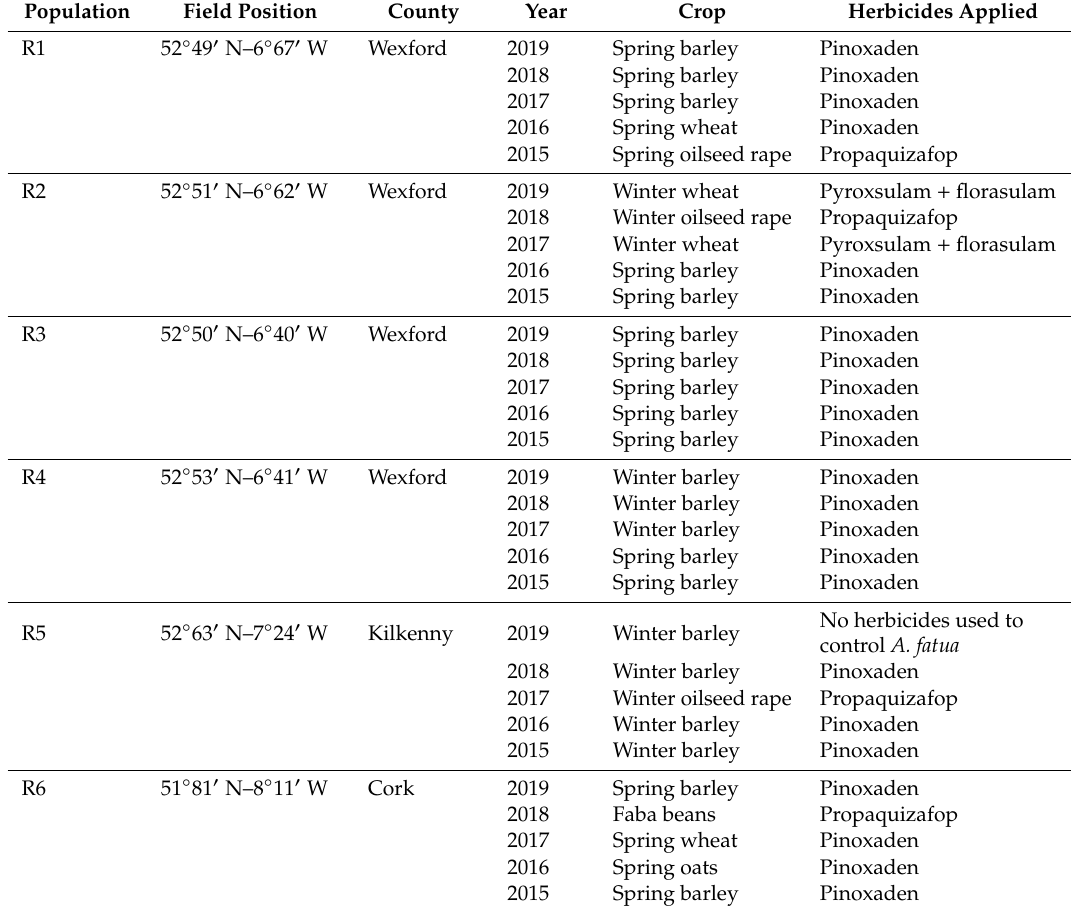
Table 1. Field history of the six A. fatua test populations collected from cereal-dominated crop rotations prior to 2019-harvest for resistance